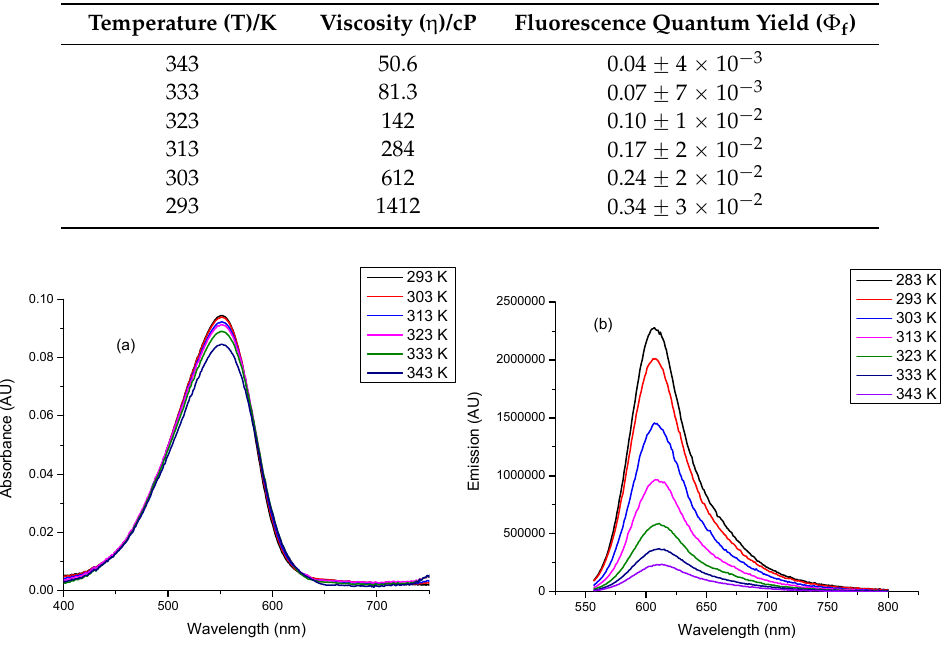
Figure 1. Absorption ( a ) and emission ( b ) spectra of dU-BZ recorded as a function of temperature in 99% glycerol/1% methanol ( v / v ) solution. Excitation wavelength = 544 nm.